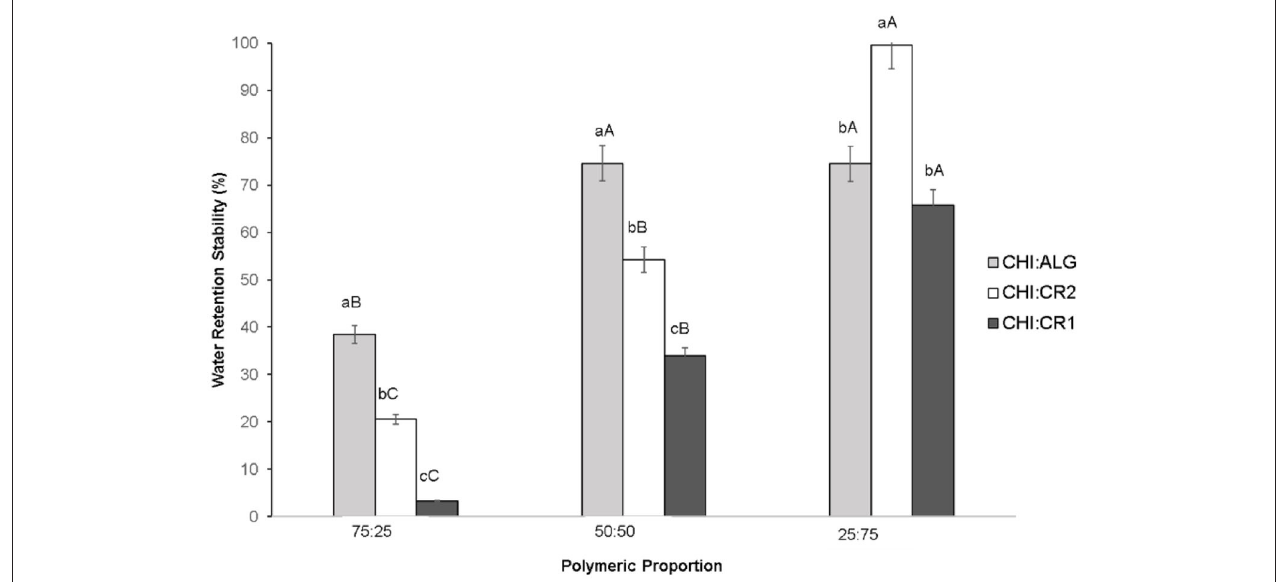
FIGURE 3 | Water retention of the complex hydrogels (CHI:ALG, CHI:CR1, and CHI:CR2) at different polymer ratios (75:25, 50:50, and 25:75). Different uppercase letters indicate a significant difference (p 0.05) in the same complex at different polymer ratios. Different lowercase letters indicate a significant difference (p ≤ in the same polymer ratio of different Complexes.